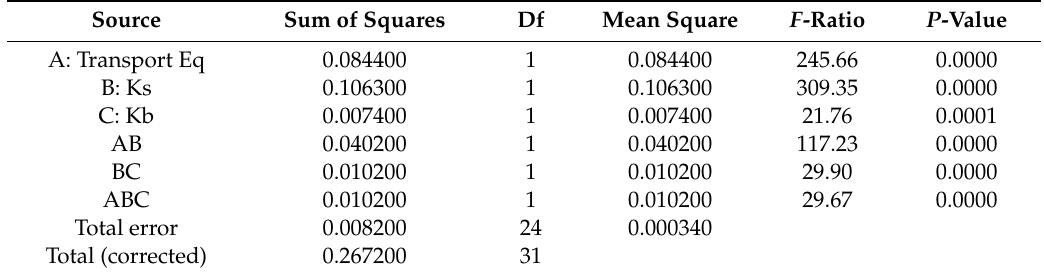
Table 5. Analysis of Variance (ANOVA) results for the 2 k